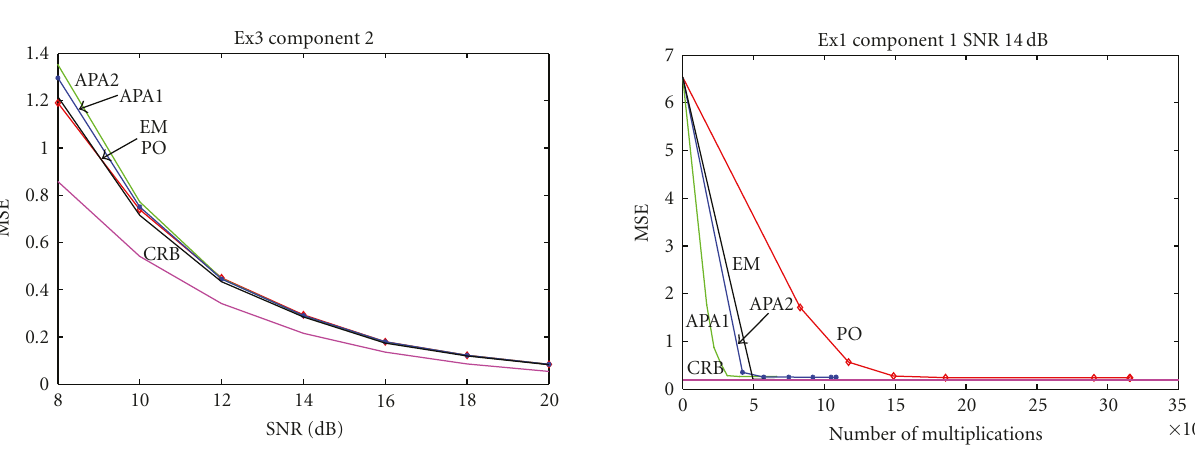
Figure 6: Experimental MSE versus SNR for Ex3 component 2.